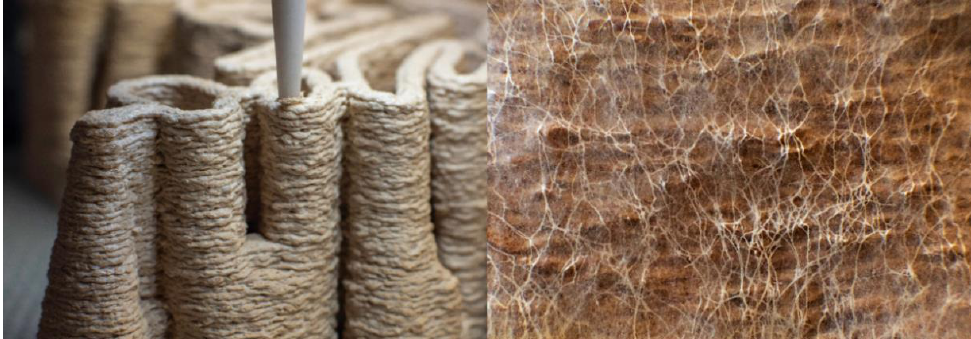
Figure 3. Extrusion of pulp ( left ), and hyphae growing on printed surface ( right ). Photo by author.